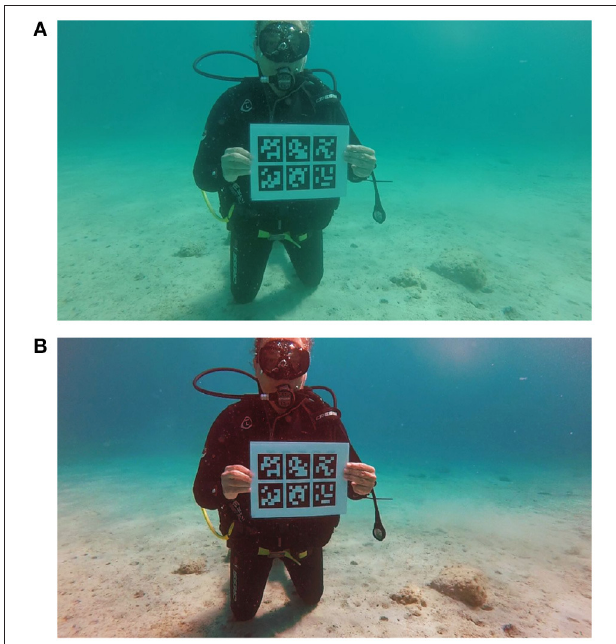
FIGURE 6 | Image of marker on a seafloor (A) processed by the SP algorithm (B)